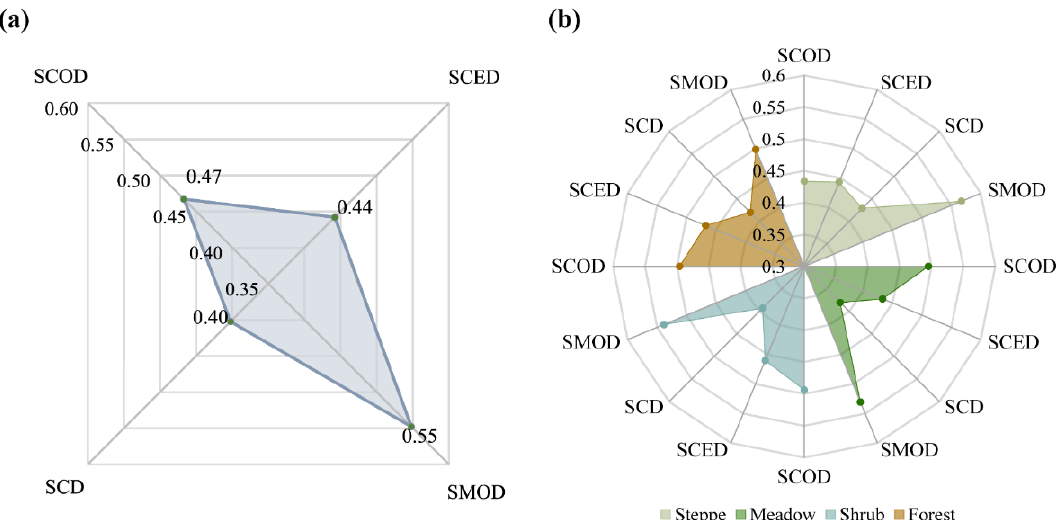
Figure 5. Mean GRG between GUD and snow cover phenology metrics for the pixels with a significant correlation ( p < 0.01) ( a ) over the whole study area and ( b ) among the four vegetation types. Pixels with a significant correlation ( p < 0.01) between the GUD and snow cover phenology metrics were also used for the sensitivity analysis over the entire study area (Figure 6) and for the four vegetation types (Figure 7). The sensitivity of the GUD to snow cover phenology reflects the flexibility and direction of change in the GUD in response to snow cover variations.